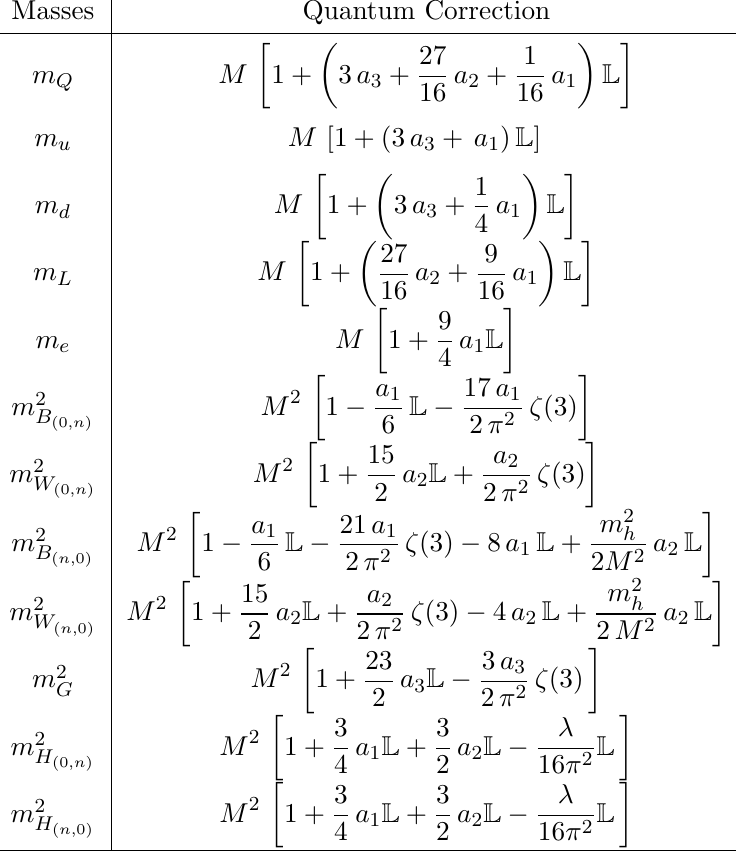
Table 4 . The one-loop corrections to the masses of the KK excitations. In each case, M refers to the corresponding tree-level